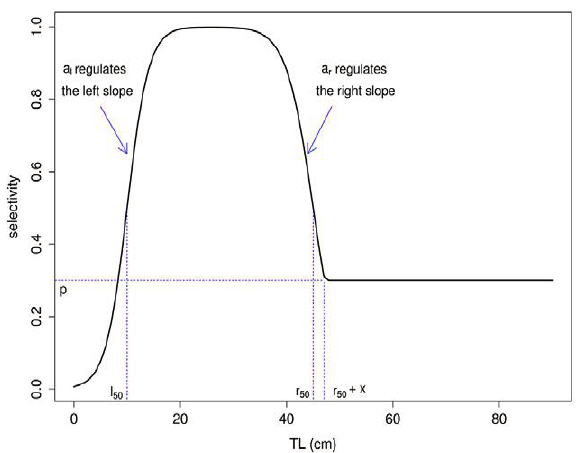
Fig. 3. – Example of the double logistic selectivity curve, with a constant right tail, used to reproduce the selectivity of